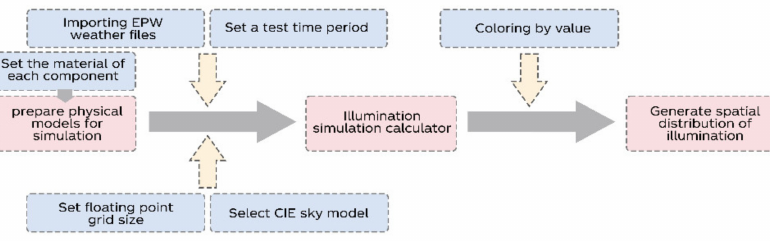
Figure 3. The programming of illuminance simulation.